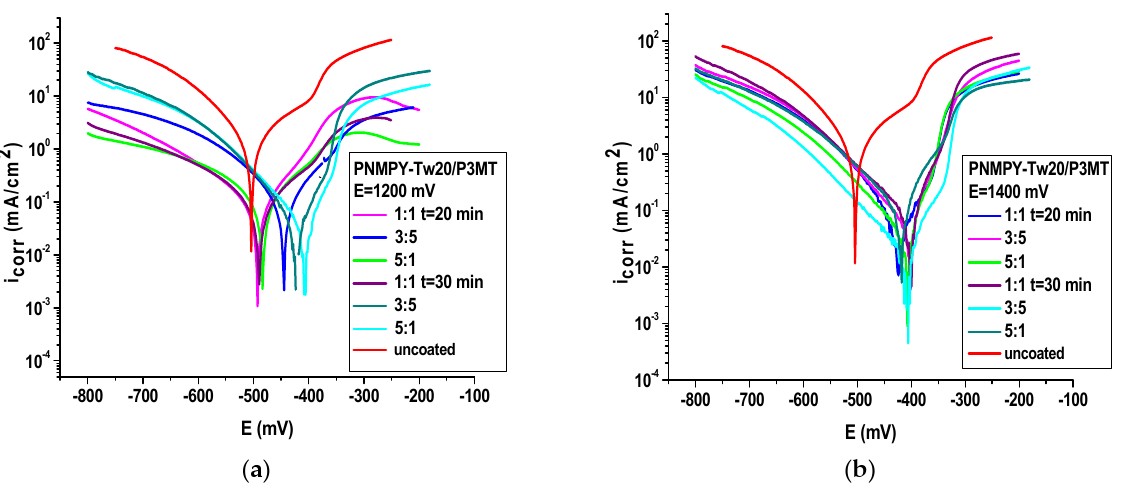
Figure 6. Polarization curves of PNMPY-TW20/P3MT coated and uncoated on OLC 45 electrode in 0.5 M H 2 SO 4 by potentiostatic procedure at 1.2 V ( a ) and 1.4 V ( b ) potential applied at differing molar ratio, and the electrodeposition has been admitted for 20 and 30 min.